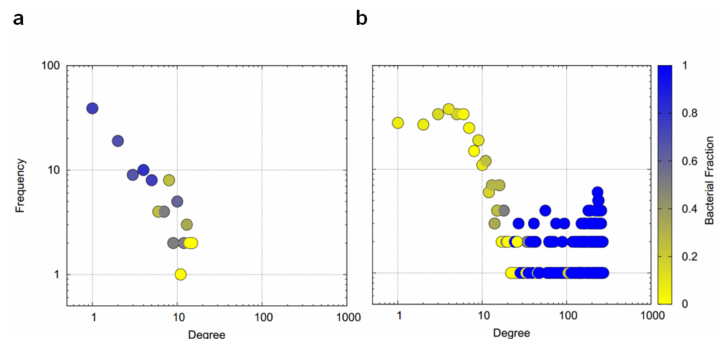
Figure 1. Degree distribution of co-occurrence networks. Color indicates the fraction of bacterial fragments at the respective degree levels, ranging from yellow indicating archaeal fragments only to blue indicating bacterial fragments only. Networks are based on Rsa I digestion. ( a ) Network derived from bulk soil samples; ( b ) Network derived from single particle samples.